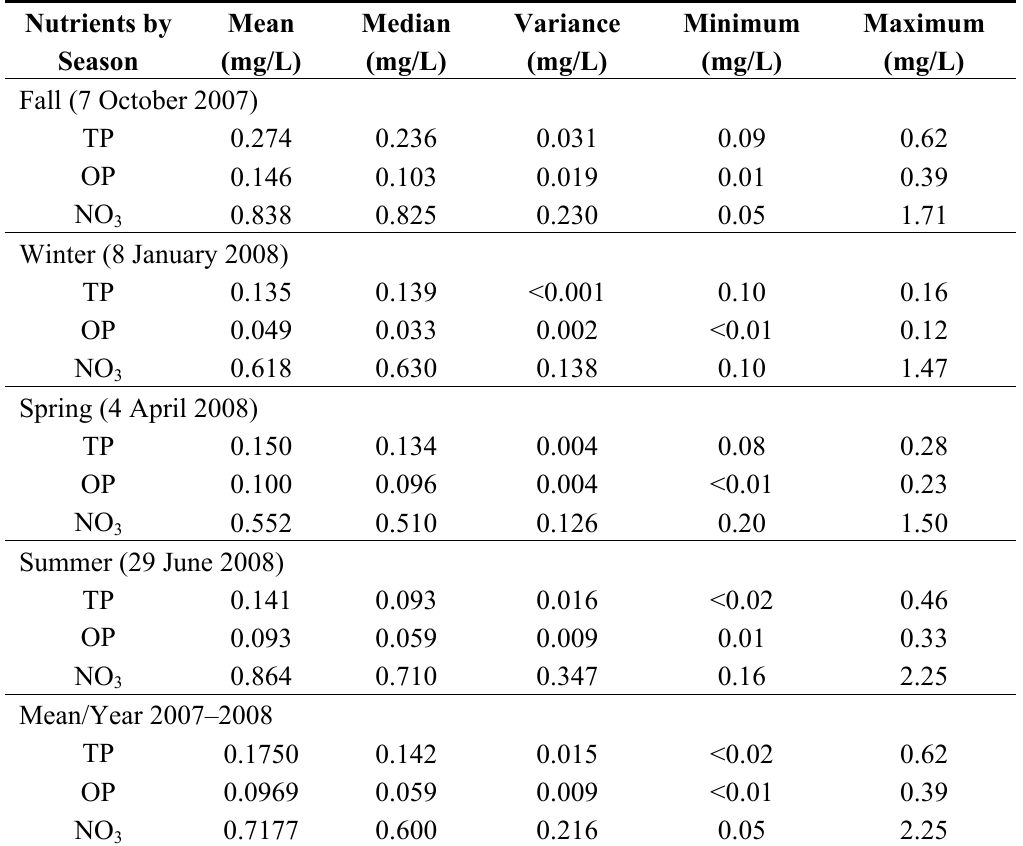
Table 1. Mean, median, variance, minimum, and maximum total phosphorus (TP), orthophosphate (OP), and nitrate (NO ) concentrations in mg/L by season ( n = 12) and 3 for the year. TP recommended stream criteria: U.S. Environmental Protection Agency